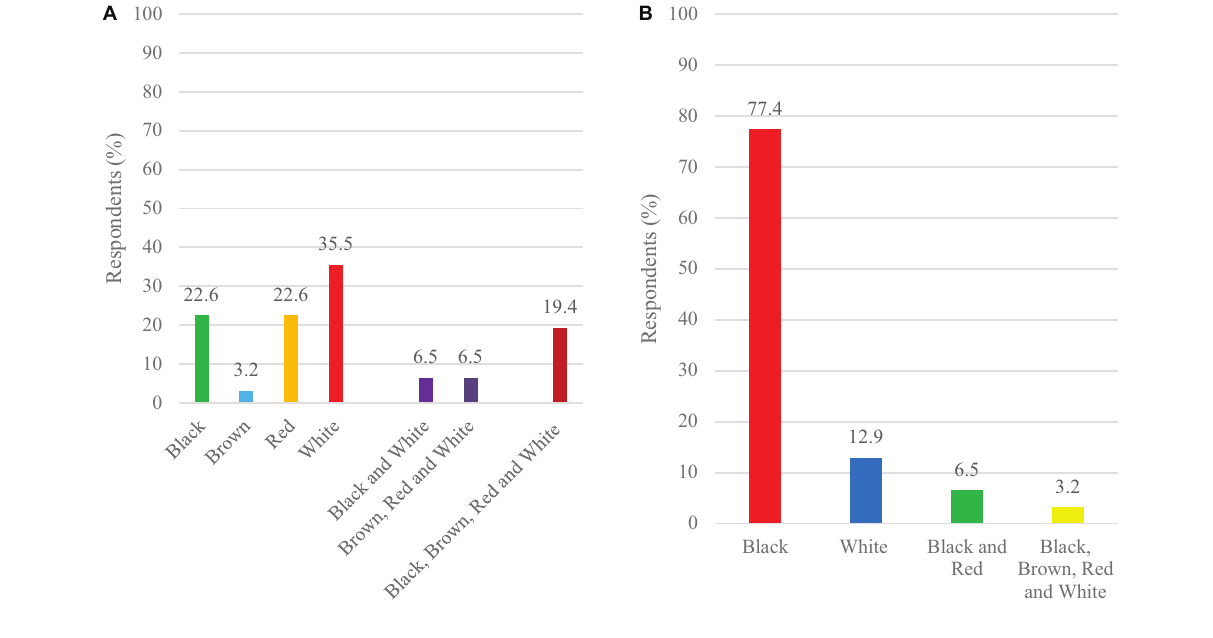
FIGURE 10 | Farmer’s color preferences for (A) food and (B) commercial